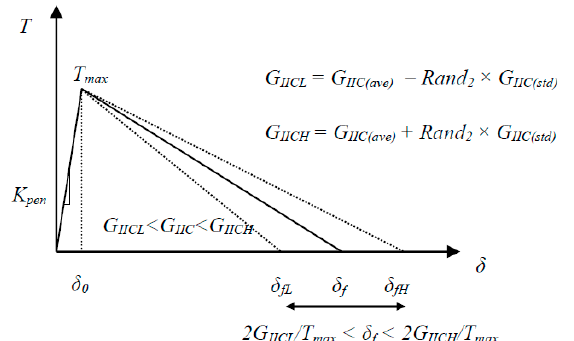
Figure 6. Proposed stochastic bilinear traction–separation behavior ( Rand 2 is a random number taken from a two-parameter Weibull distribution; G IICL and G IICH correspond to the lower and upper limits of G IIC . It was assumed that the onset of crack propagation was mainly influenced by the resin itself, and given that the resin showed more deterministic material properties, T max was assumed to have no variation in the model.